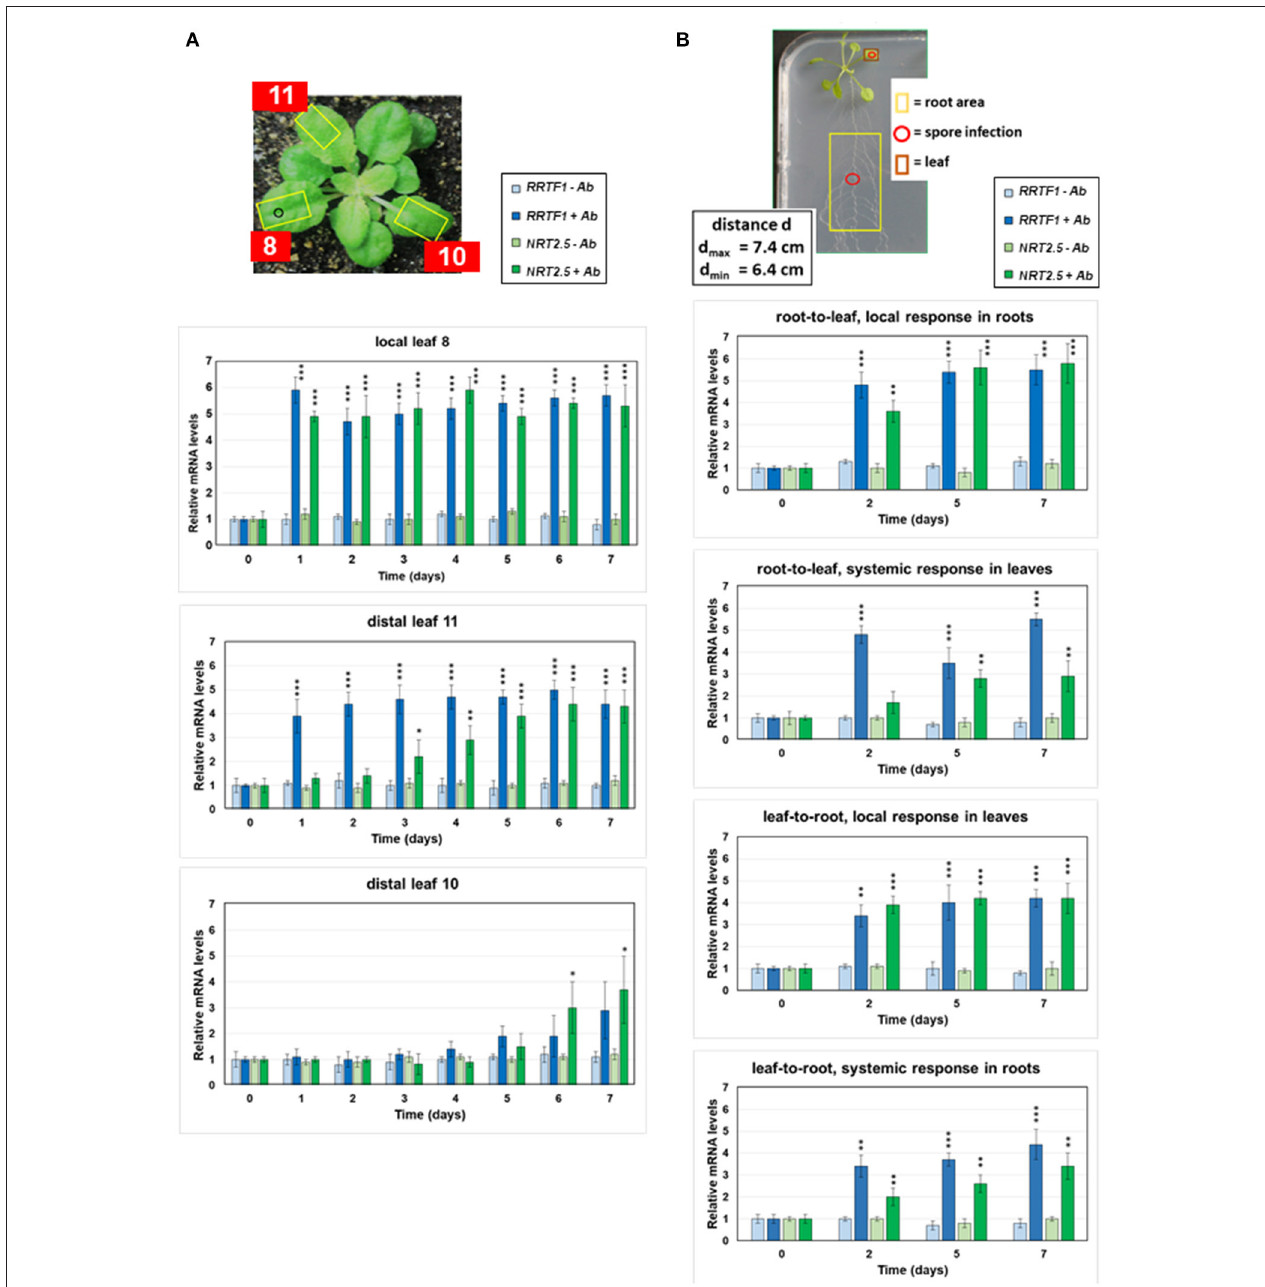
FIGURE 1 | Local and systemic induction of RRTF1 (blue bars) and NRT2.5 (green bars) mRNA levels by A. brassicae spore infection. (A) The picture shows the experimental set-up. The leaf numbers of 4-week-old seedlings, the A. brassicae infection area (o) and the sections used for RNA extraction (yellow squares) are shown. RRTF1 and NRT2.5 mRNA levels in the local infected leaf no. 8 and the distal leaves no. 11 and 10. At day 0, infection was performed with an A. brassicae spore suspension and the mRNA accumulation was followed in infected (darker bars) and mock (water)-treated (lighter bars) seedlings over a period of 7 days. (B) The picture shows 2-week-old Arabidopsis seedlings grown in square Petri dishes for the measurements of RRTF1 and NRT2.5 mRNA levels in local and systemic tissues. The spore infection occurred either at the leaf or at the root (red o). The local and systemic leaf areas harvested for RNA isolation are indicated (red and yellow squares). The graphs show RRTF1 (blue bars) and NRT2.5 (green bars) mRNA levels in local and systemic tissues 0, 2, 5, and 7 days after application of an A. brassicae spore suspension (darker bars), lighter bars show water controls. All RNA data are based on 6 independent experiments with 10 seedlings for each treatment. The mRNA levels for the 4 datasets at day 0 were set as 1.0 and all other values were expressed relative to them ( ± SEs). Asterisks indicate significant differences of the values for Alternaria-treated tissue compared to the corresponding water control at the same time point, as determined by Student’s t -test (* P ≤ 0.1; ** P ≤ 0.01; *** P ≤ 0.001). *** > , all higher values have P ≤ 0.001 compared to mock-treated